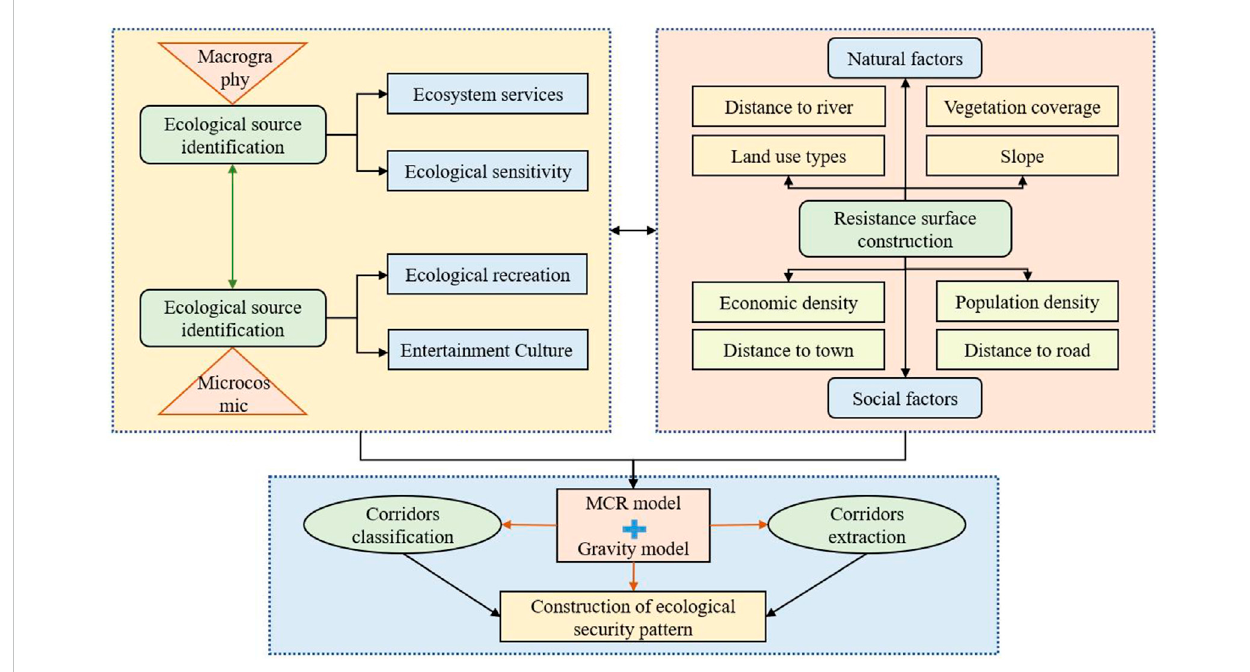
FIGURE 2 Research